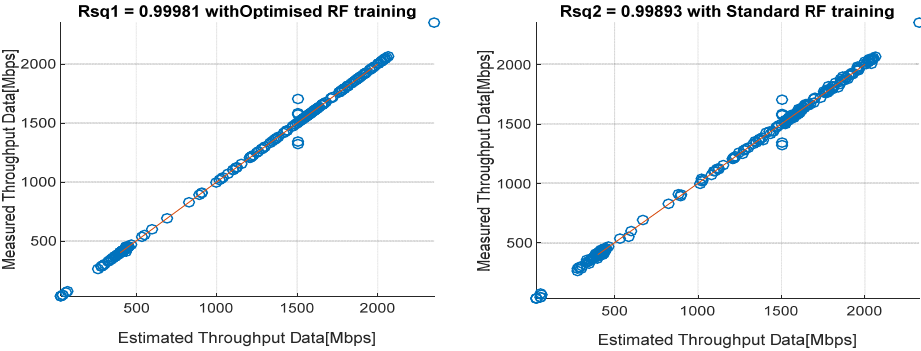
Figure 13. Predicted throughput quality correlation performance of the proposed RF-LS-BPT model and standard RF model at 25 m distance.